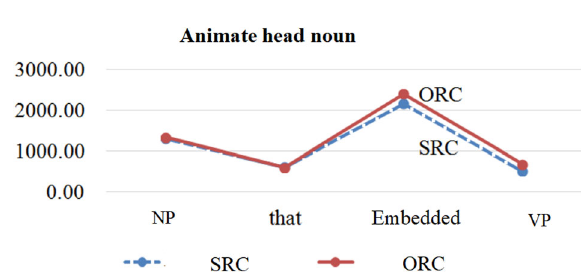
Fig. 2 Reading times for SRC and ORC with animate head nouns in different regions. This fi gure shows the results of reading times for SRC and ORC with animate head nouns in different regions in Experiment